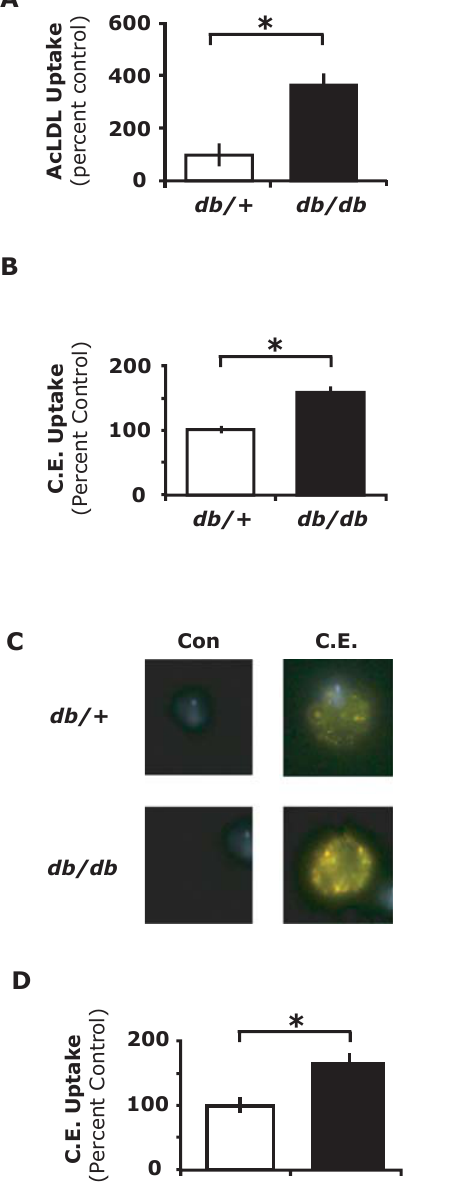
Figure 1. PerM W s from db/db mice have increased AcLDL and cholesteryl ester uptake. A, db / + and db/db mice were administered 5 m g/mL of Dil-AcLDL by IP injection. After 4 h, PerM W s were collected and Dil-AcLDL uptake measured by flow cytometry. B , db/ + and db/db mice were administered 5 m g/mL of bodipy-cholesteryl ester by IP injection. After 4 h, PerM W s were collected and cholesteryl ester uptake measured by flow cytometry. C , bodipy-cholesteryl ester (C.E) or carrier (Con) were administered as in A for 4 h. PerM W s cholesteryl ester uptake was examined using fluorescent microscopy. Results are representative of three independent experiments. D , PerM W s were collected from db/ + and db/db mice and cultured for 30 min ex vivo. Cells were then incubated with 5 m g/mL bodipy-cholesteryl ester (C.E.) and cholesteryl ester uptake measured by flow cytometry at 4 h. Results for A, B and D represent the average of three independent experiments 6 SEM. *: p , 0.05.